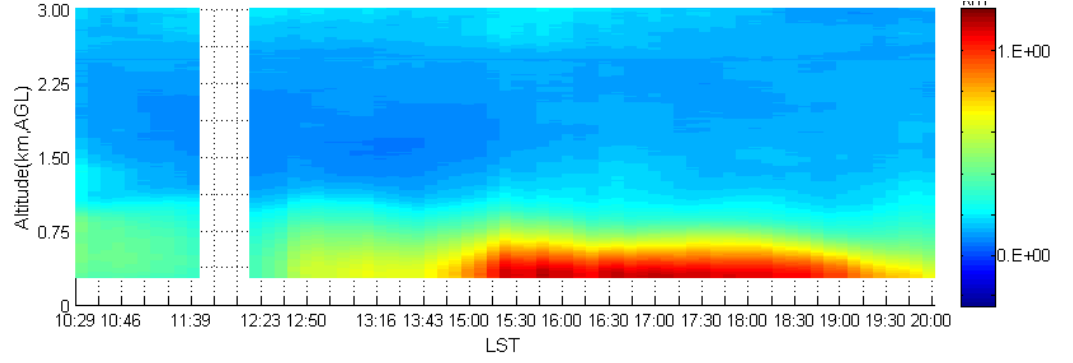
Figure 13. Temperal evolution of the extinction coefficient on 3 June